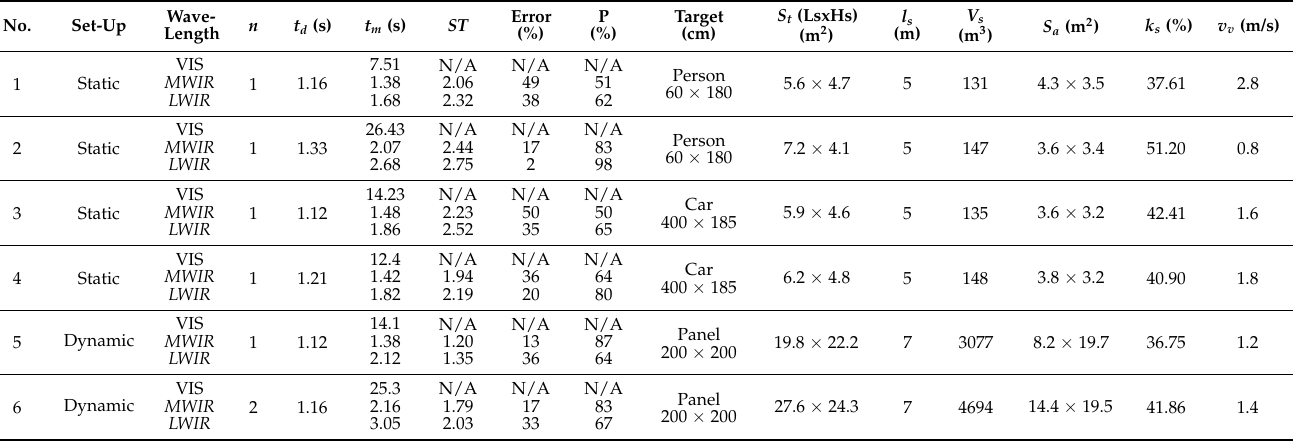
Table 4. Results of experimental tests in field